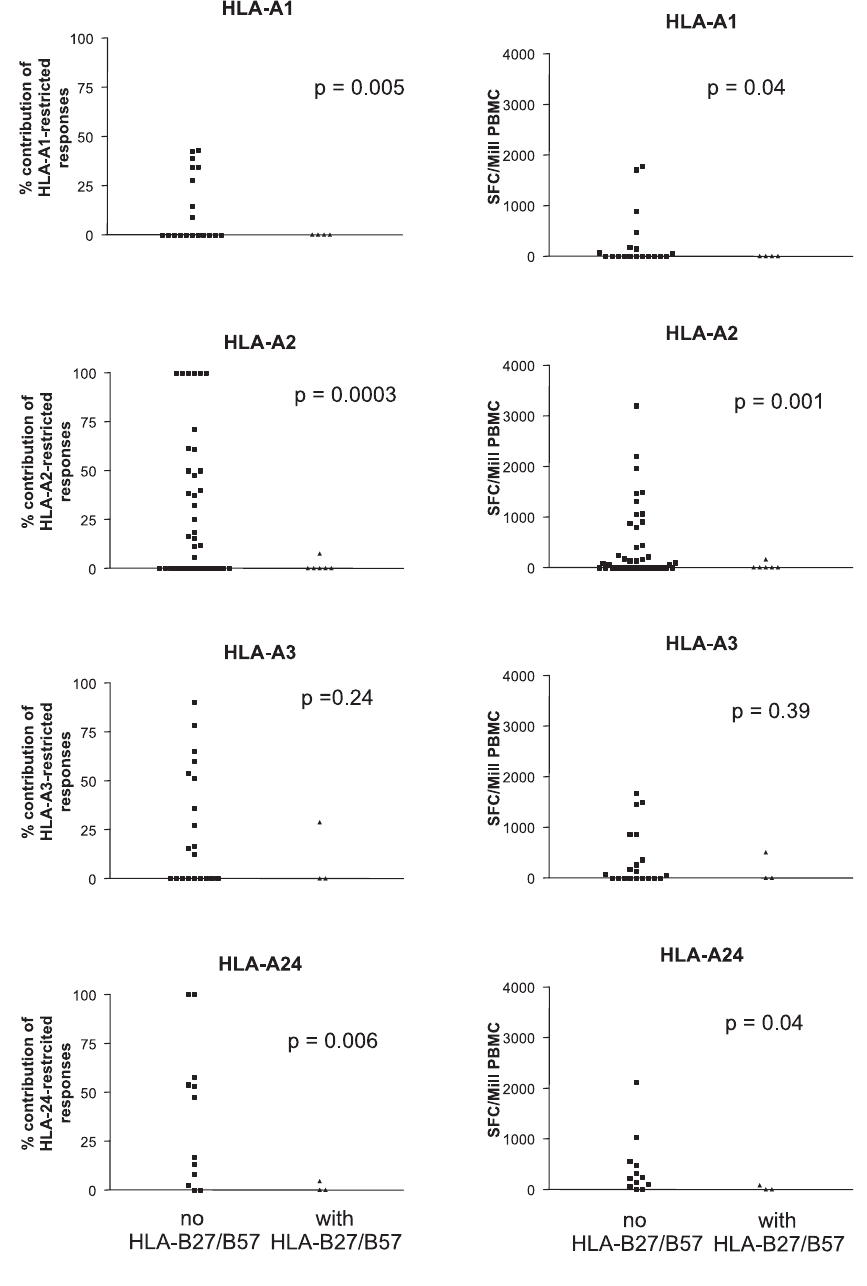
Figure 4. Immunodomination of HLA-B57- and HLA-B27-Restricted HIV-1-Specific CD8